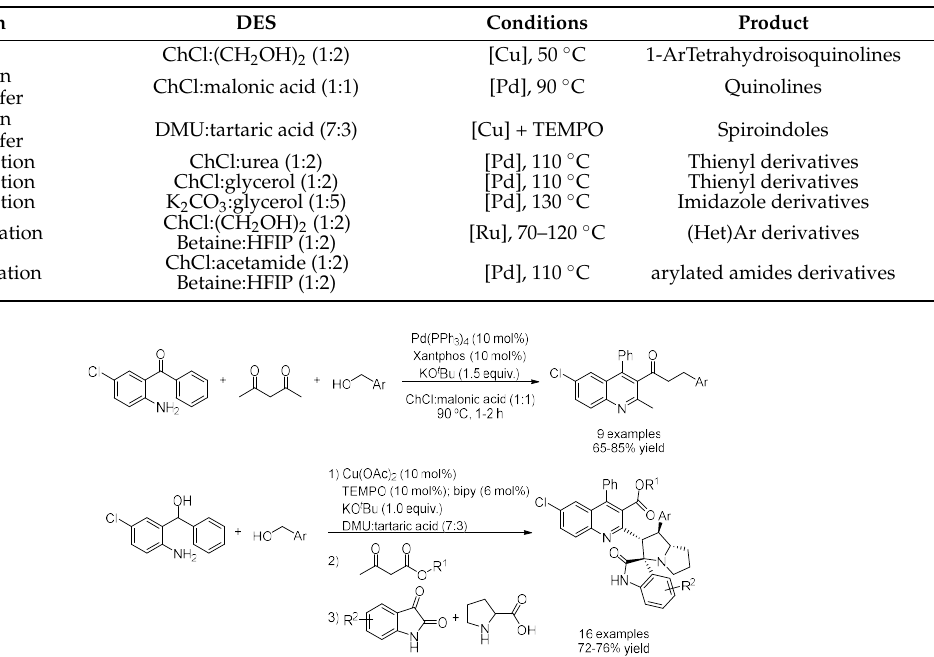
Figure 30. Sequential Friedländer condensation and C-H functionalization.